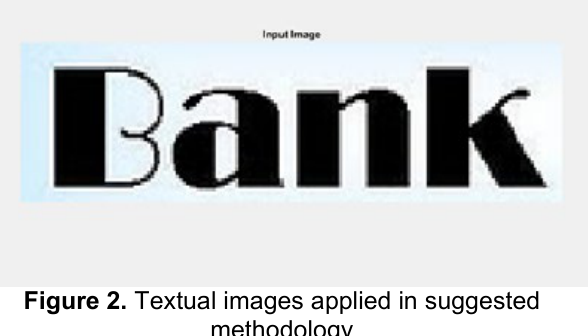
Figure. 3 illustrated images obtained after executing a pre- processing step and then watershed segmentation performed and